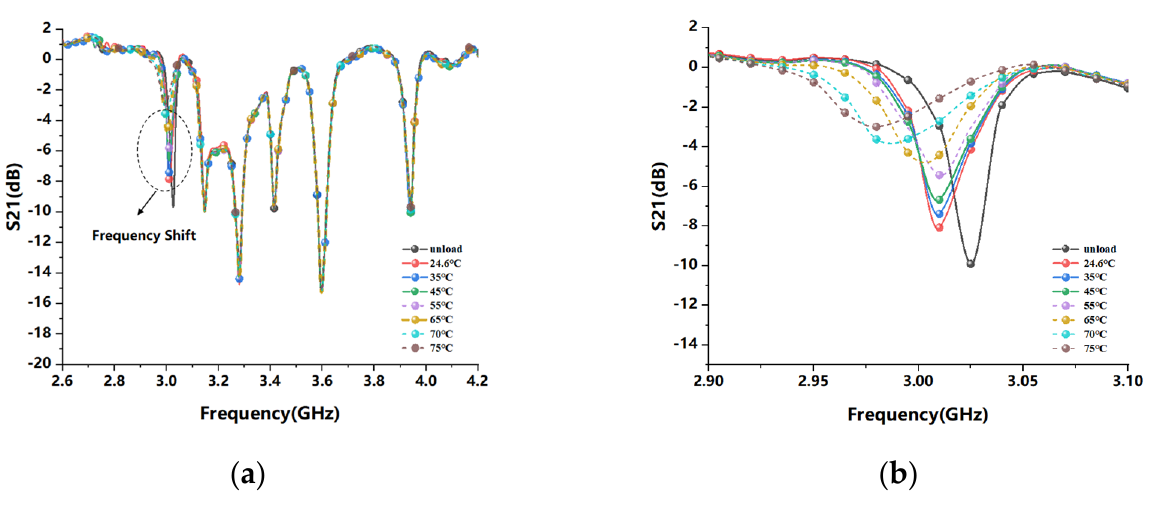
Figure 13. CSRR temperature sensing unit resonance response: ( a ) S21 resonance response curve change of tag sensor; ( b ) Partial amplification CSRR resonance unit S21 curve change.